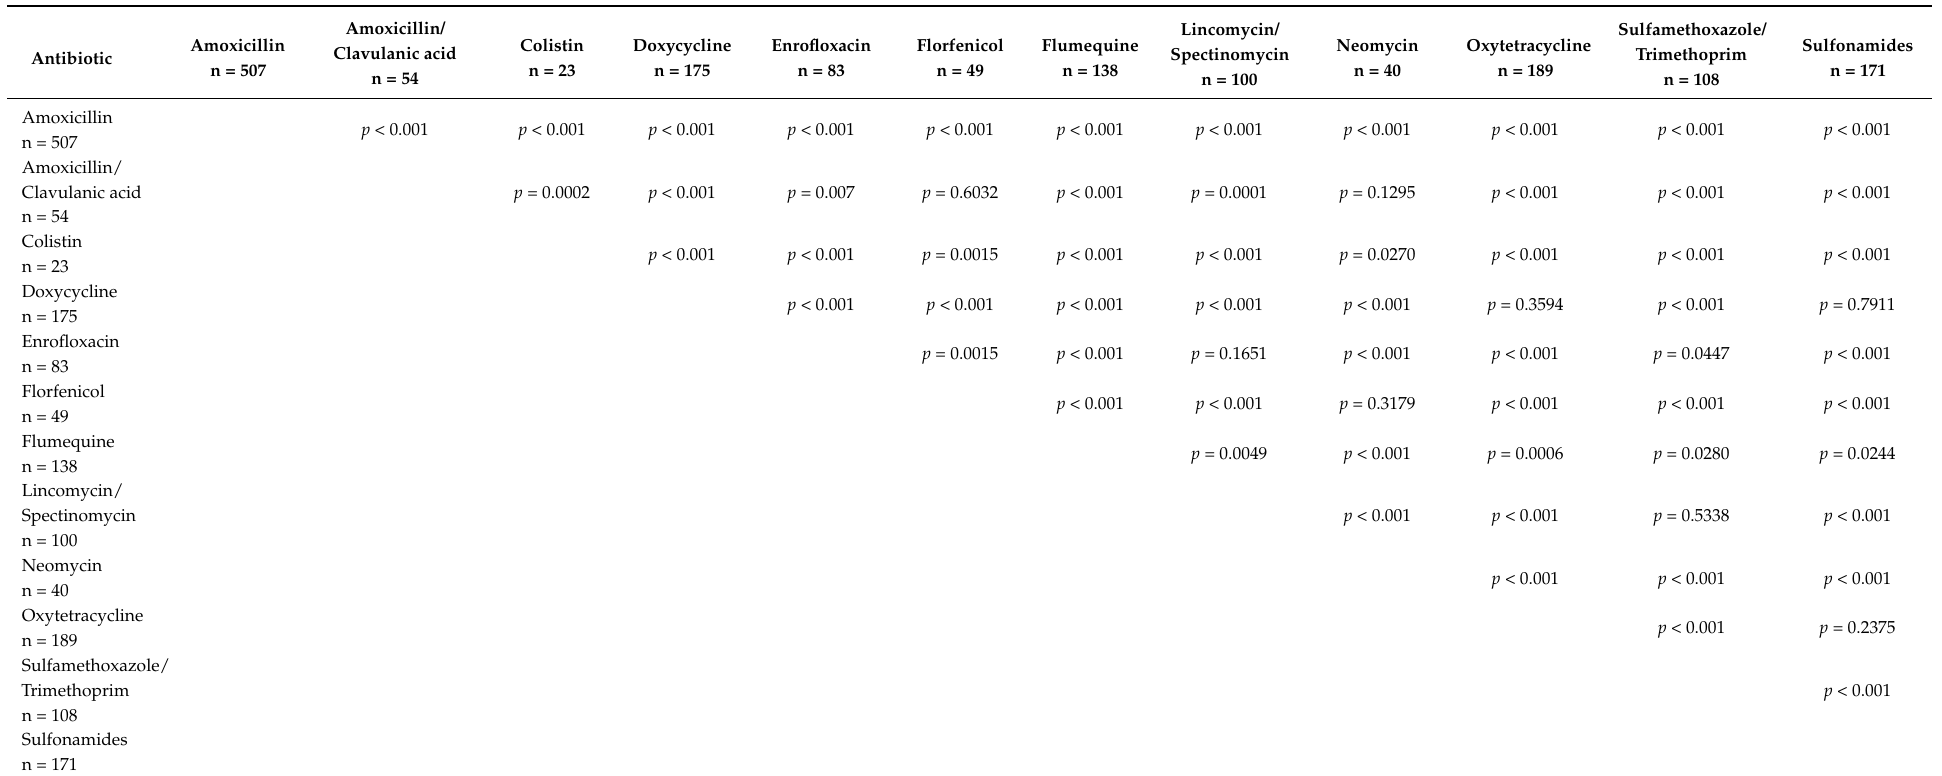
Table 3. Evaluation of statistical significance between the number of Klebsiella spp. strains resistant to the tested antibiotics between 2019 and 2022. p < 0.05 indicates pairs of antibiotics that show statistically significant difference in the resistance